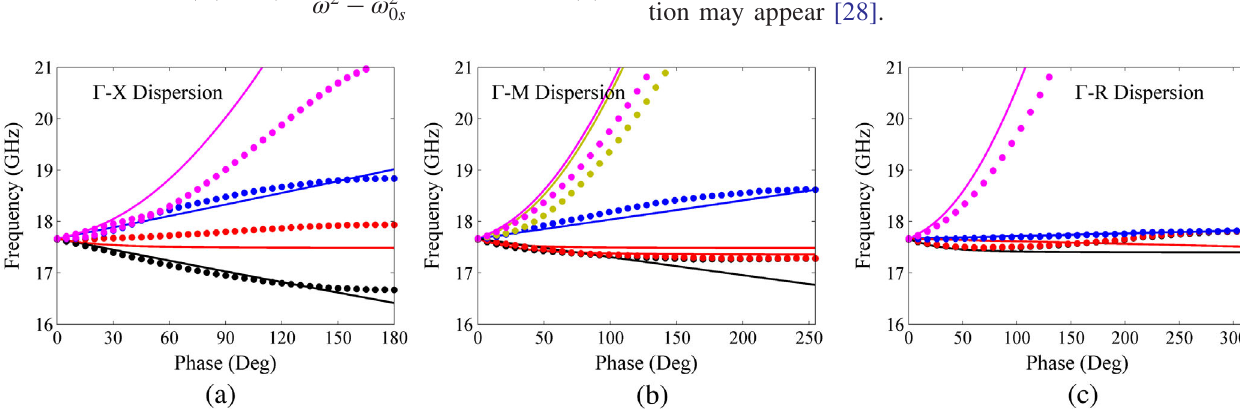
FIG. 4. Fitting results of the dispersion curves. HFSS results are in dotted lines, and the fitting curves are in solid lines. The optimized parameters are α 1 ¼ − 0 . 0209 , α 2 ¼ − 0 . 0209 , and α 3 ¼ 0 . 0156 . (a) Γ − X . (b) Γ − M . (c) Γ − R . Modes 1, 2, 3, and 4 are denoted with black, red, blue, and magenta, respectively. In the Γ − M region, mode 4 splits into two